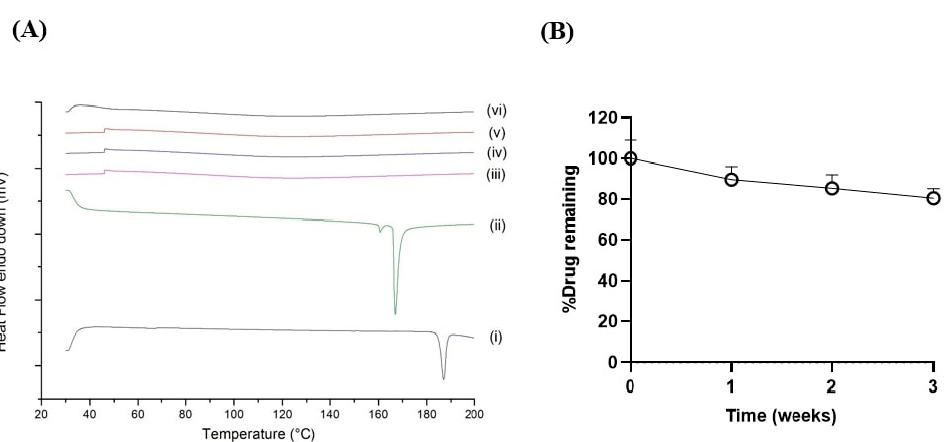
Figure 6. Accelerated stability testing at storage conditions (40°C, 75%RH) ( A ) thermograms of bedaquiline (i), SBE- β -CD (ii) and BDQ-CD at week 0 (iii), 1 (iv), 2 (v) and 3 (vi). ( B ) Percentage drug remaining (%) in the CD inclusion complex versus time (weeks). Data represented as mean ± SD ( n = 3).